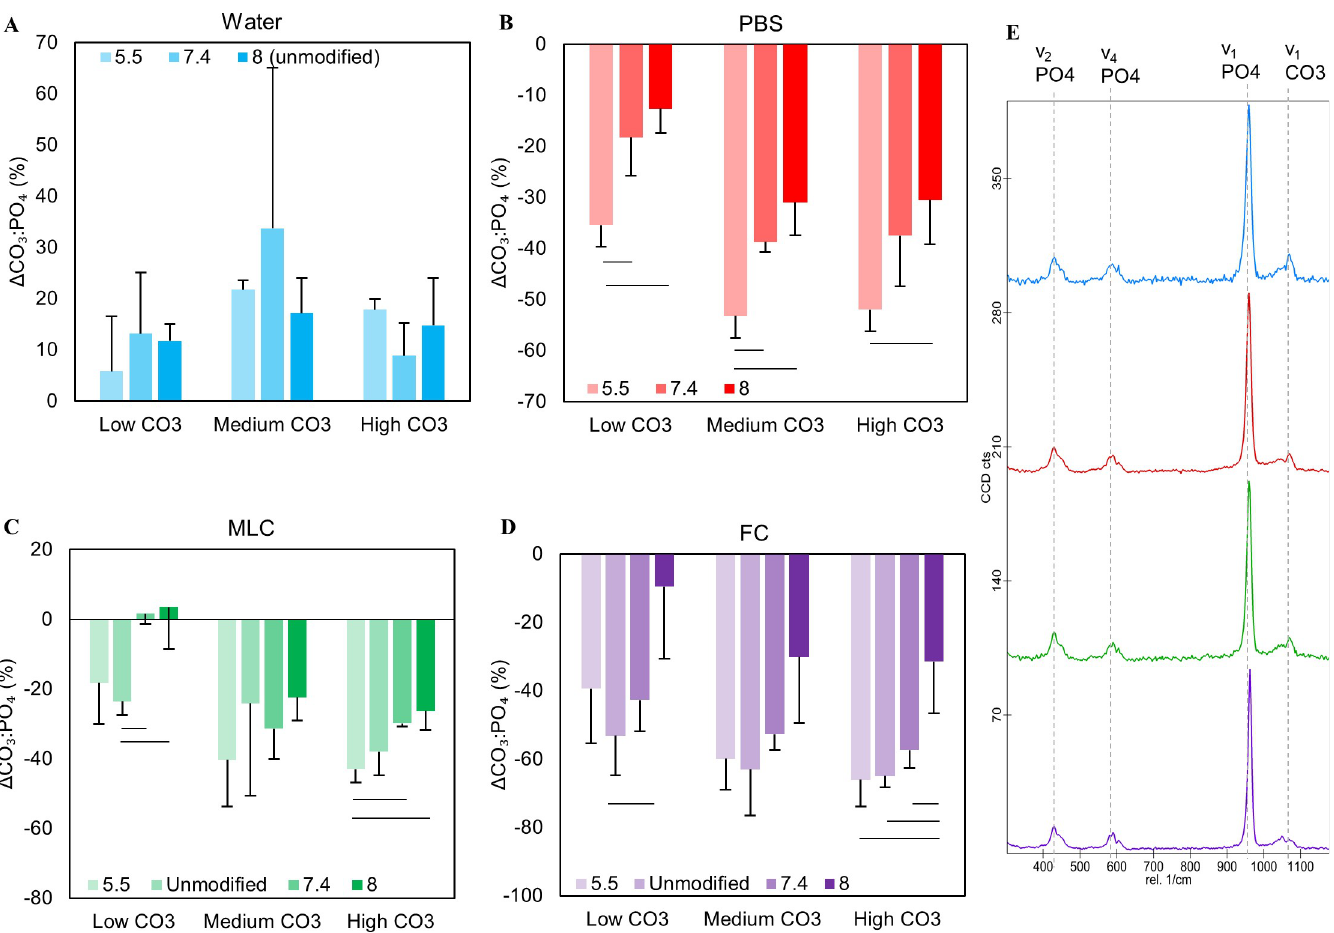
Fig 5. Δ Carbonate: Phosphate ratios of CAP powders after exposure as a function of initial pH. CO 32- :PO 42- ratios decreased for PBS, MLC, and FC after solution exposure (B-D) while Water increased, suggesting an increase in carbonate amount (A) . For PBS, CO 32- :PO 42- significantly decreases as pH i decreases at all wt% CO 32- (B) . MLC and FC trended similarly to PBS (C, D) , suggesting a loss of carbonate in apatite. Raman spectra of 6 wt% carbonated apatite after exposure in water (blue), PBS (red), MLC (green), and FC (purple) solutions at pH 5.5 (E)